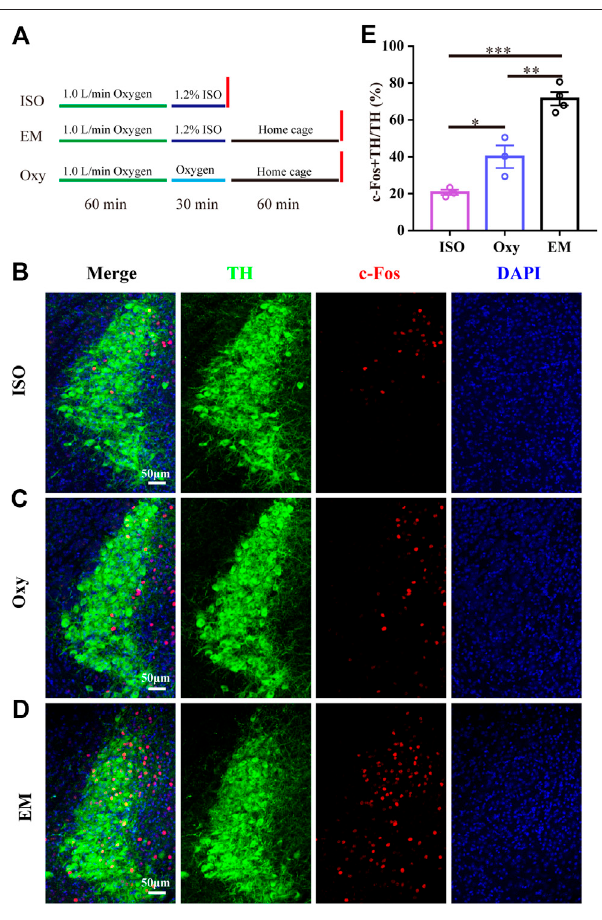
FIGURE 1 | LC TH neurons are active during passive emergence from iso fl urane anesthesia. (A) The experimental protocol for the c-Fos quanti fi cation experiments in three groups of mice. First group (ISO) received 1.2% iso fl urane anesthesia and was euthanatized before awakening. The second group (EM) received the same iso fl urane anesthesia treatment andunderwentpassiveemergencefromanesthesia.Thethirdgroup(Oxy)did not underwent iso fl urane anesthesia and received oxygen. (B – D) Representative photomicrographs showing the co-localization of c-Fos (red) and TH neurons (green) in LC for ISO group, Oxy group and EM group, respectively. (E) The percentage of c-Fos + TH/TH in ISO group ( n (cid:1) 3), Oxy group ( n (cid:1) 3) and EM group ( n (cid:1) 4). Data were analyzed by one-way ANOVA with post hoc Bonferroni multiple-comparison test, * p < 0.05, ** p < 0.01, *** p < 0.001. Data shown as means ±